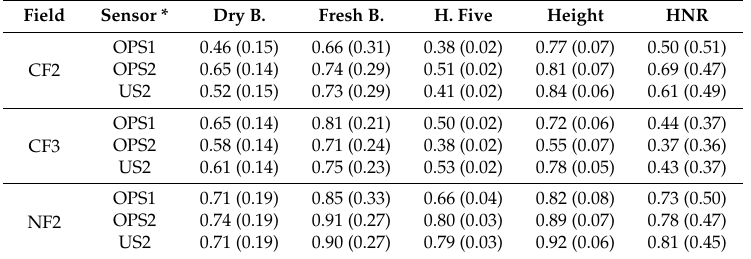
Table 5. Performance of crop sensors measured by coefficient of determination and root-mean-squared error to predict crop parameters of cotton cultivated in conventional and narrow row